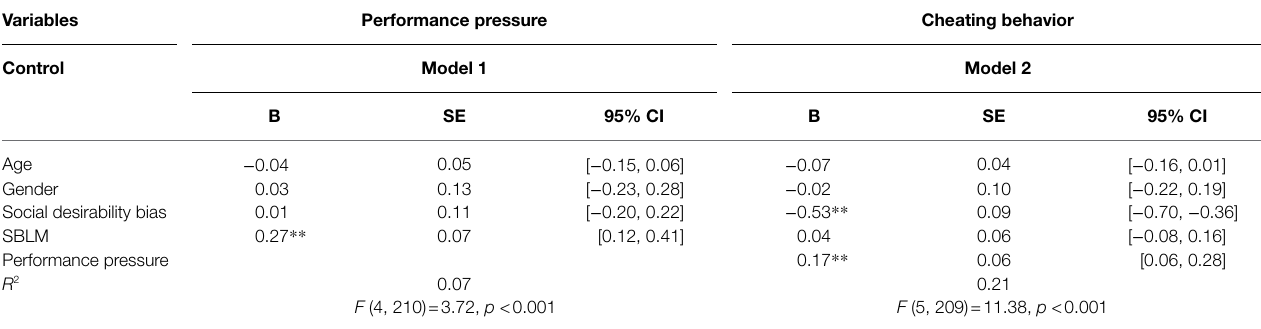
TABLE 4 | Regression results for performance pressure and cheating behavior (Study 1).